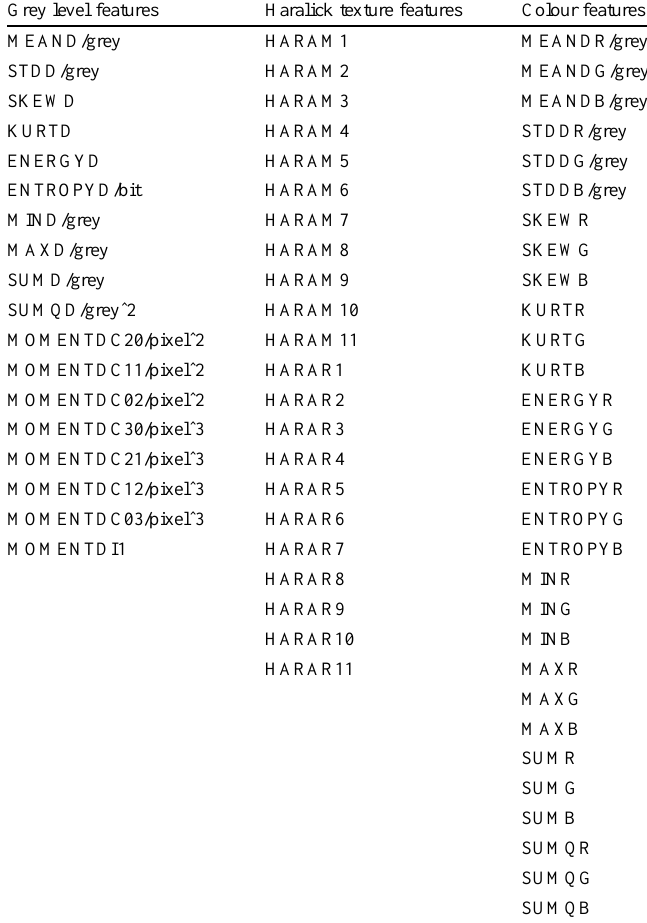
Measurement features obtained for each element. For detailed definition see [1] Grey level features Haralick texture features Colour